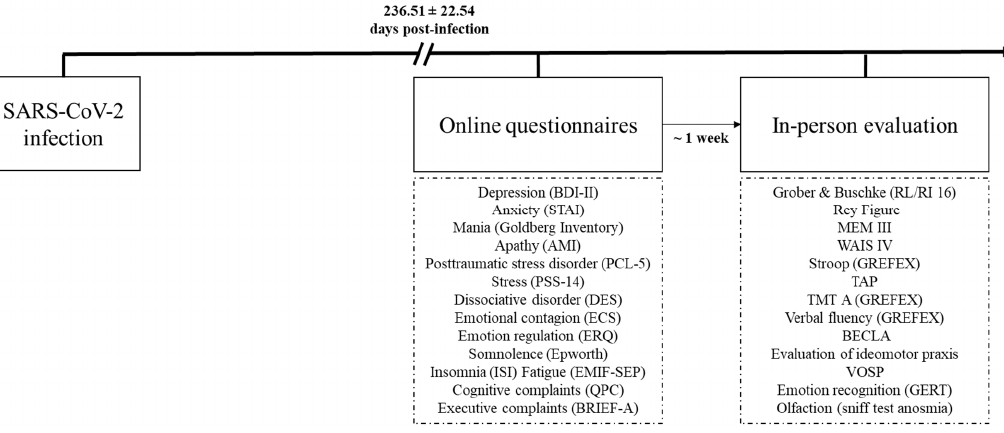
Figure 2. Testing procedure .